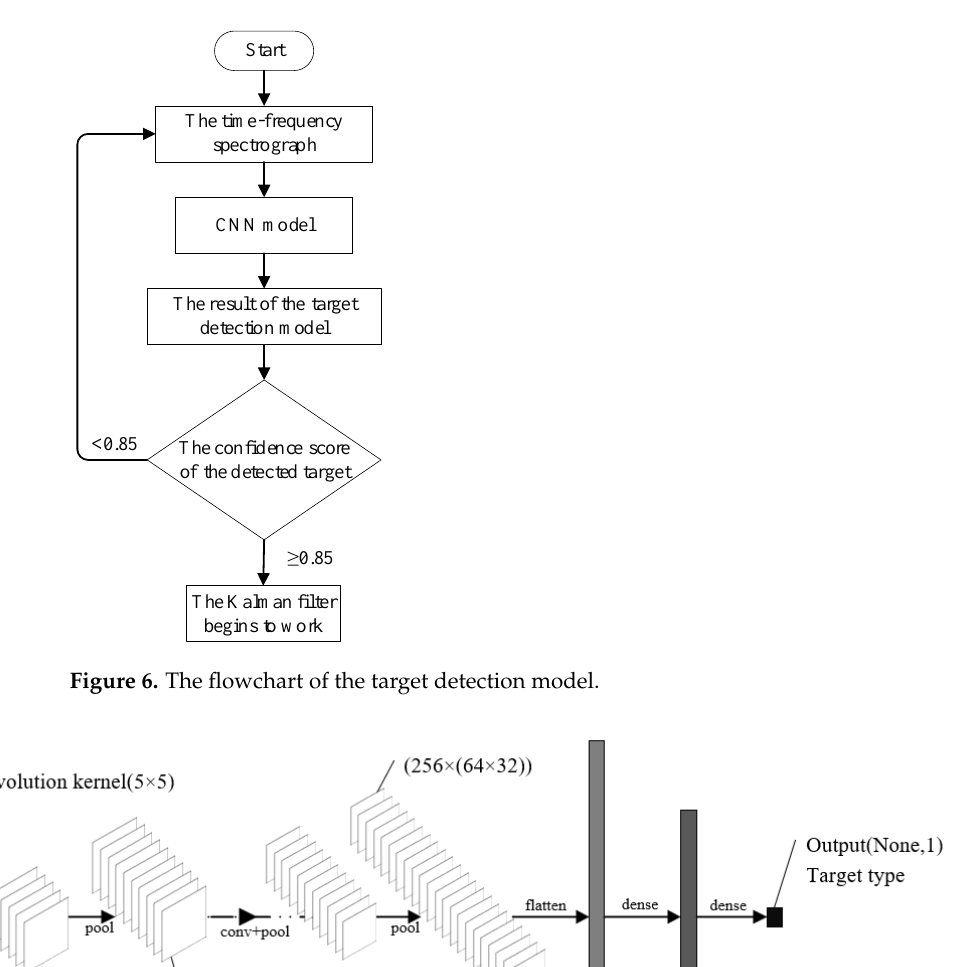
Figure 7. Network structure of the target detection model.